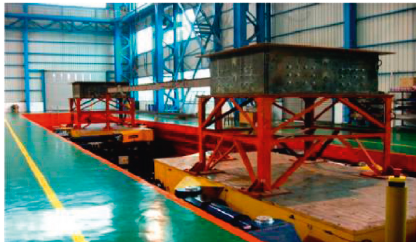
Figure 4: Seismic array of China Merchants Chongqing Com- munications Research and Design.